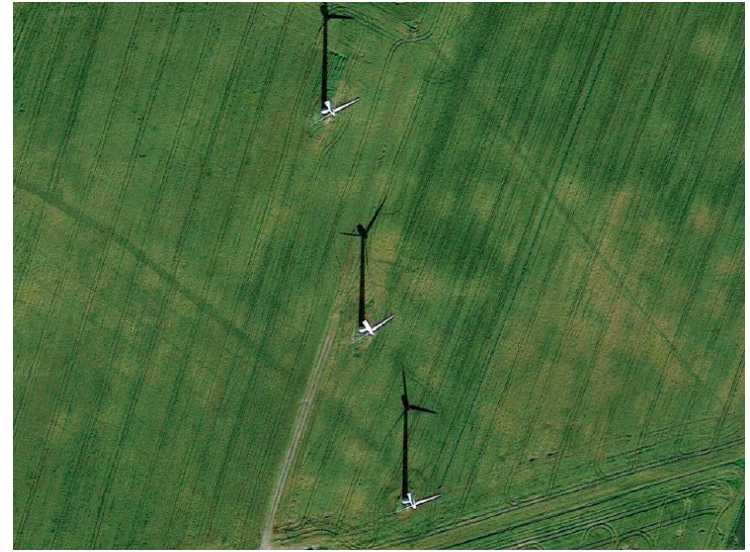
Figure 2. Top view of the wind farm (Source: Google Earth).